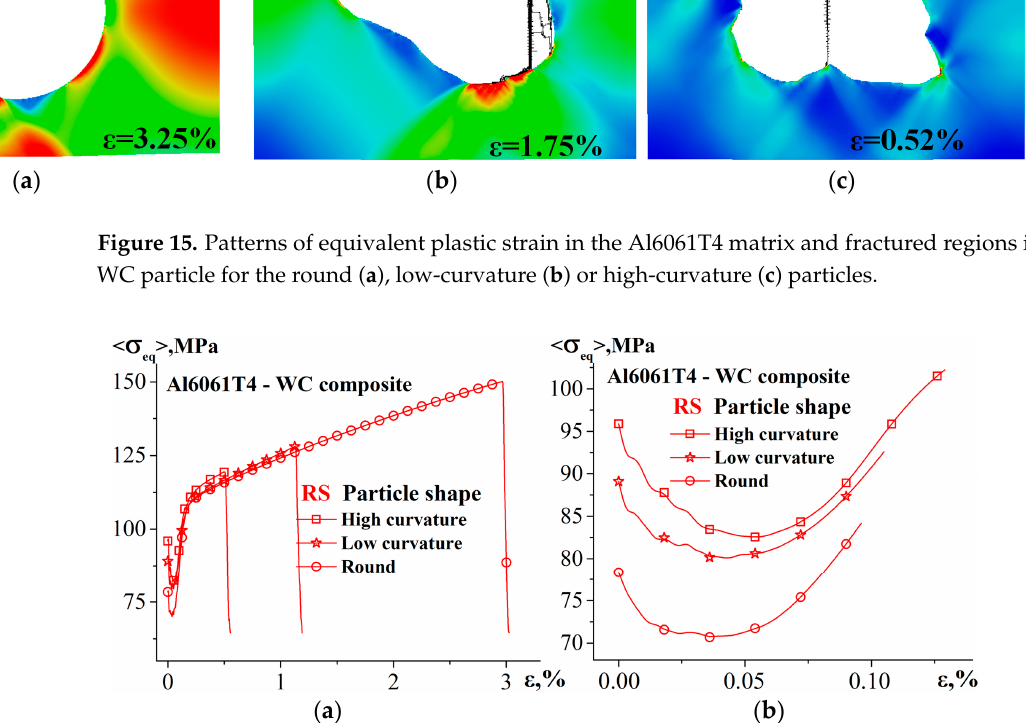
Figure 16. Stress–strain curves of the composites shown in Figure 15 ( a ) and their initial sections ( b ).